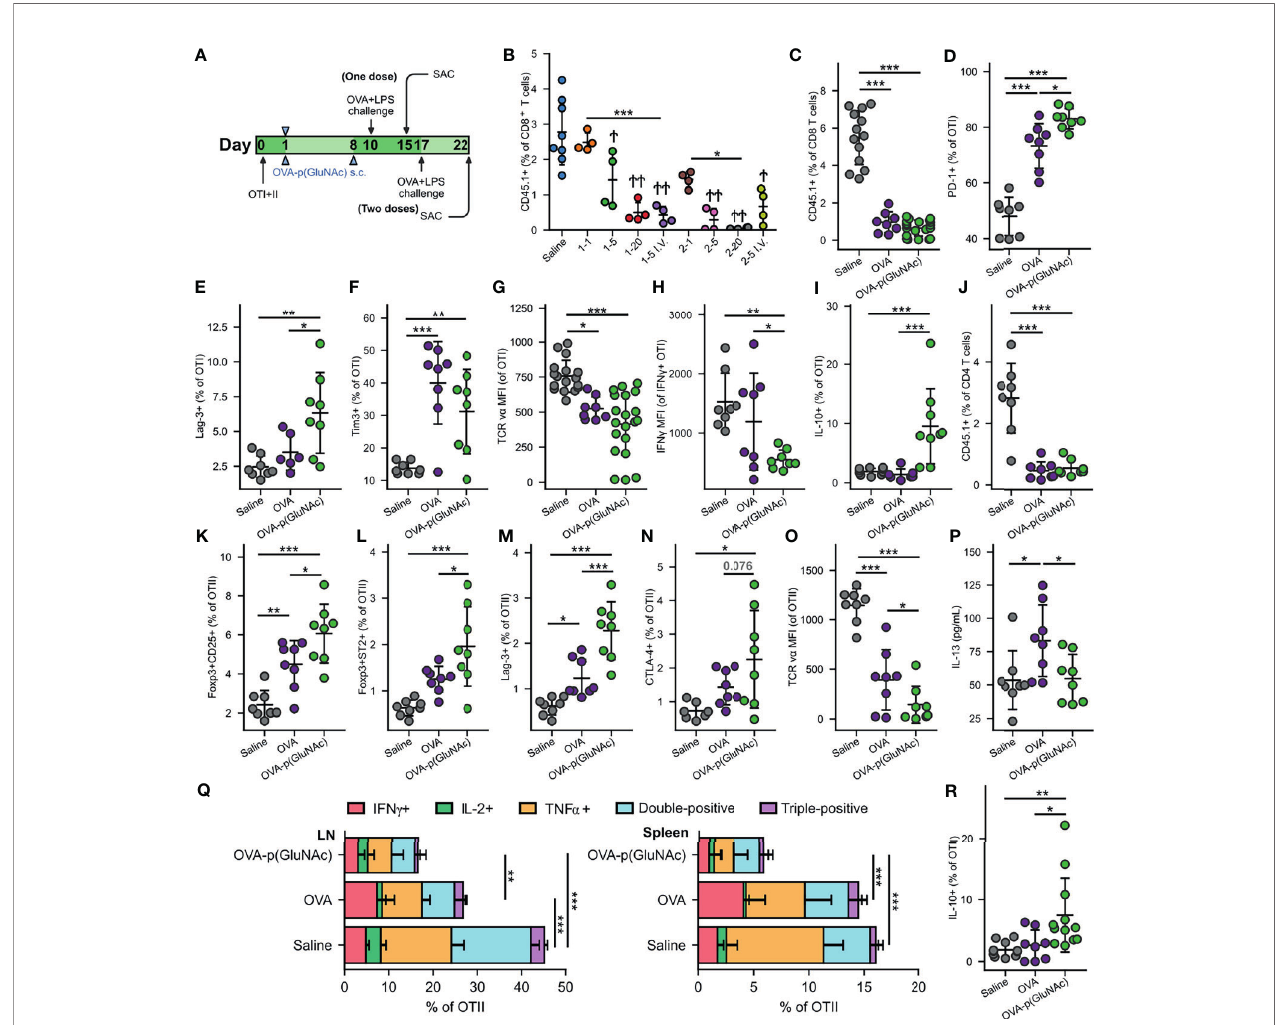
FIGURE 2 | (A) Experimental timeline of the dose-ef fi cacy study, n=4. CD45.2 + mice that had received an adoptive transfer of both OTI (CD45.1 + CD3 + CD8 + ) and OTII (CD45.1 + CD3 + CD4 + ) T cells via i.v. injection, were treated with saline or a low, mid or high dose of OVA-p(GluNAc) s.c. in all four hocks or i.v. in the tail vein (as benchmark) either once on day 1 or twice on days 1 and 8. 9 days following the last dose, on day 10 (for the groups that received one dose) or on day 17 (for the groups that received two doses), all mice were administered an OVA+LPS challenge s.c., and 5 days later, the dLNs and spleen were examined for an OVA-speci fi c response. Stars above horizontal bars represent p values with respect to the i.v. groups (*p ≤ 0.05, **p ≤ 0.01, ***p ≤ 0.001) and † indicate p values with respect to the saline group ( † p ≤ 0.05, †† p ≤ 0.01). (B) OTI CD8 + T cells recovered from dLNs at time of sacri fi ce. Plot legends are as follows: 1-1 (1 m g s.c., once), 15 (5 m